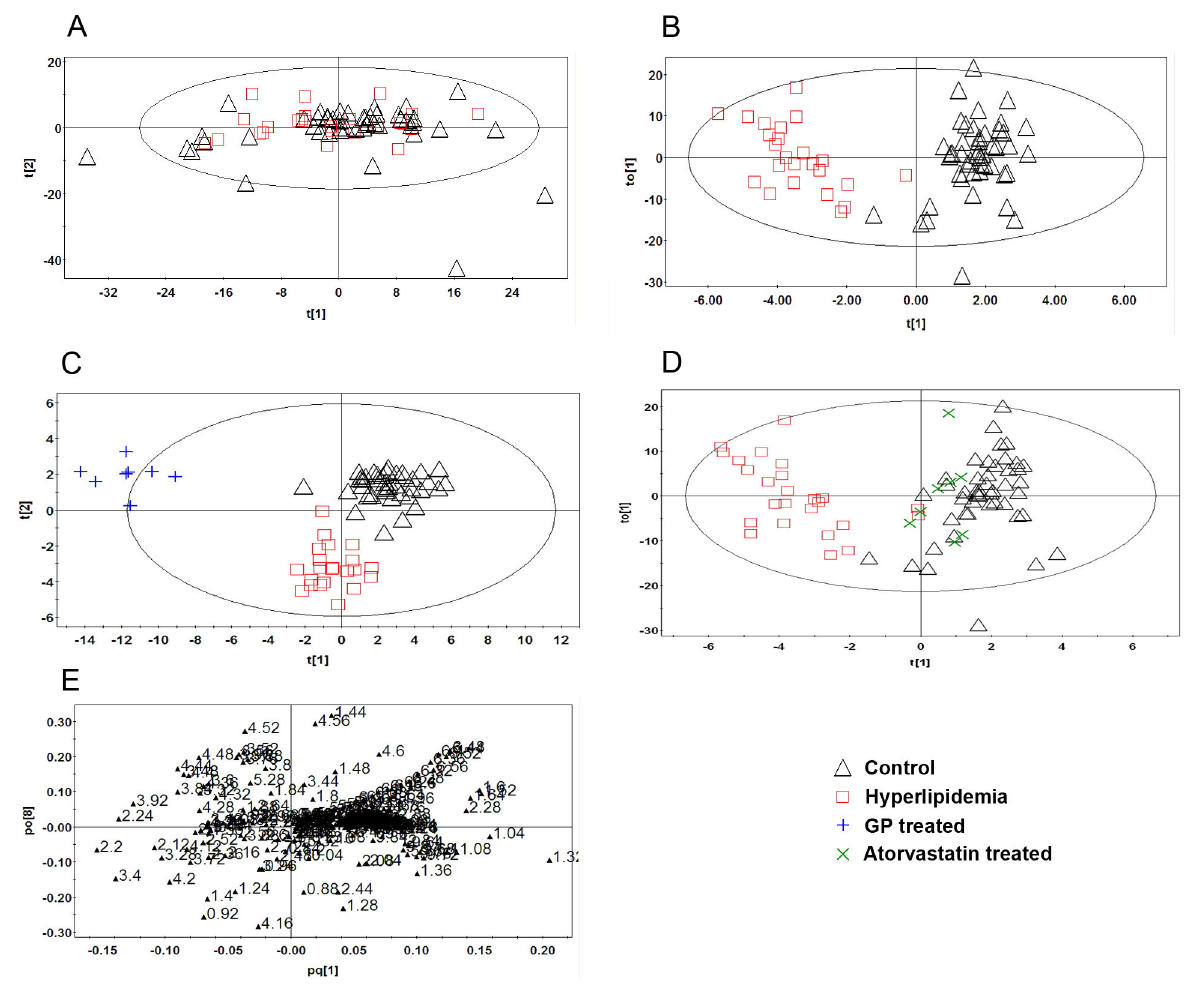
Figure 3. PR analysis of the 1 H-NMR spectra of rat plasma. (A): PCA analysis of the spectra of plasma from normal and hyperlipidemia rats (R 2 X=0.988, Q 2 =0.885). (B): Scores plot of the OPLS-DA analysis of the spectra from the plasma of normal and hyperlipidemia rats (R 2 X=0.925, R 2 Y=0.874, Q 2 =0.642). (C): Scores plot of the OPLS-DA analysis of the spectra from the plasma of normal, hyperlipidemia and GP-treated rats (R 2 X=0.968, R 2 Y=0.878, Q 2 =0.538). (D): Scores plot of the OPLS-DA analysis of the spectra from the plasma of normal, hyperlipidemia and Atorvastatin-treated rats (R 2 X=0.909, R 2 Y=0.522, Q 2 =0.328). (E): Loading plot of the OPLS-DA analysis of the spectra from the plasma of normal and hyperlipidemia rats.